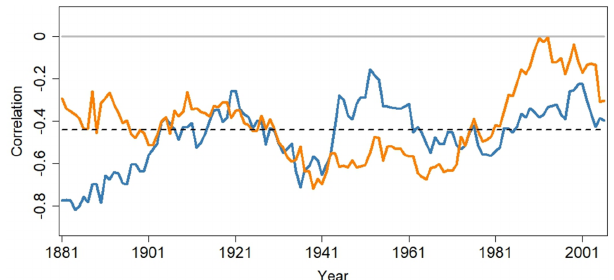
Figure 9. Sliding correlation between the Niño 3 index and the AIR anomalies for the JJ (blue curve) and AS (orange curve) seasons. The horizonal dashed line represents the 5% significance